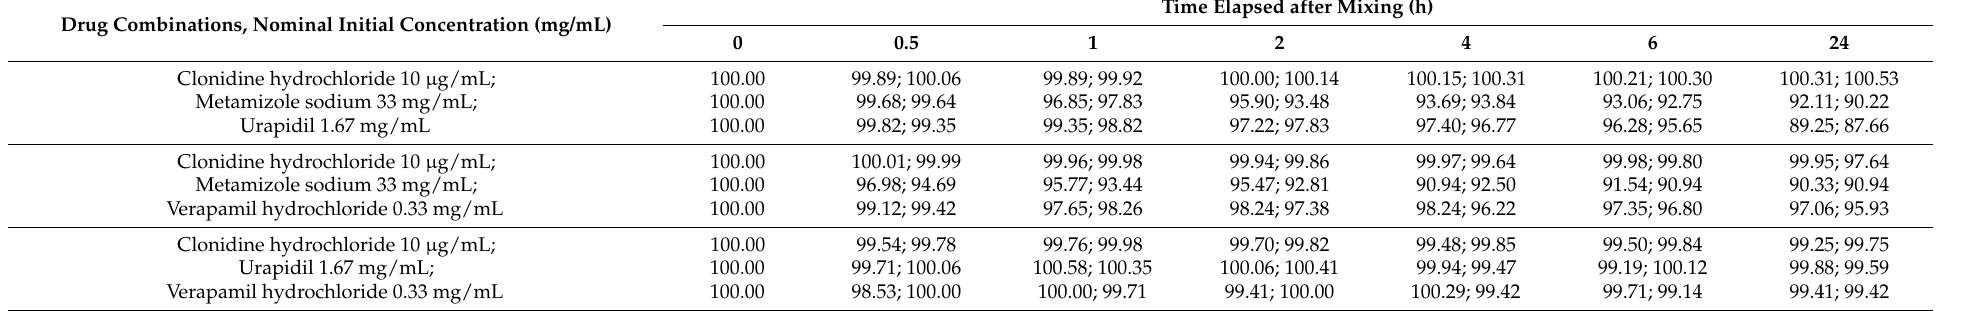
Table A6. Chemical compatibility of ternary